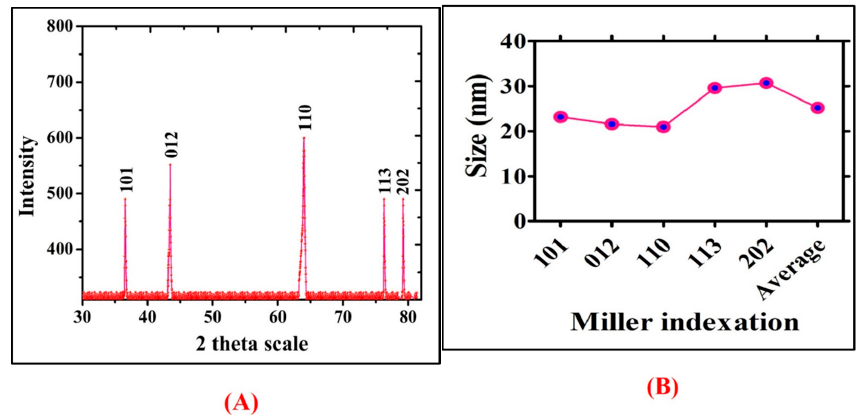
Figure 6. ( A ) XRD Spectra of the RT-NiONPs ( B ) Size calculation and Miller indexation.